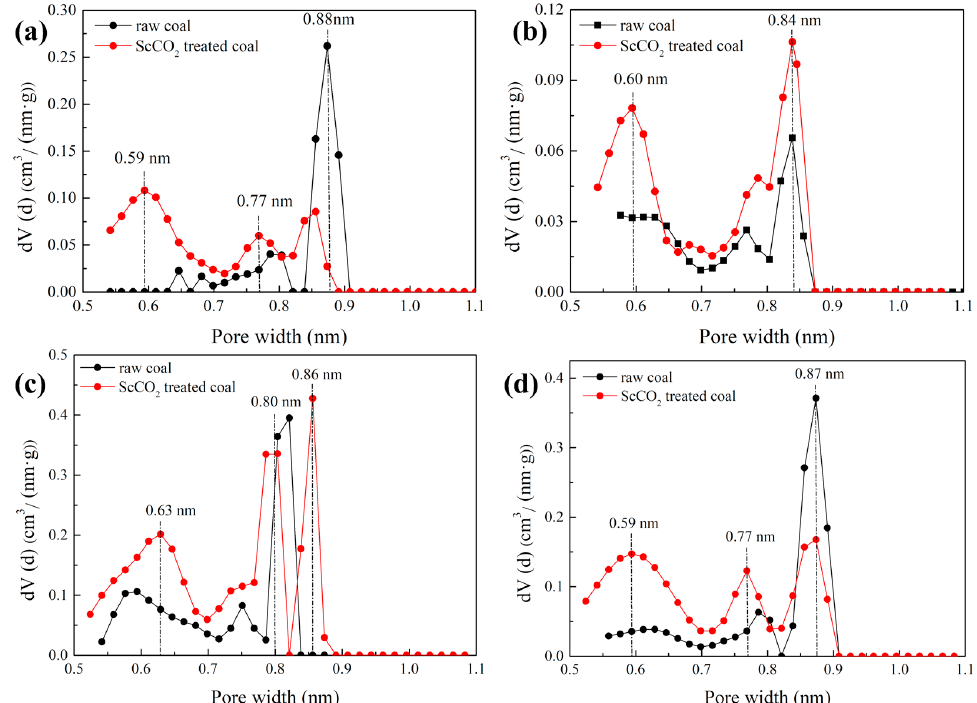
Figure 9. PSD for the raw and ScCO 2 -treated coal samples determined by CO 2 adsorption: ( a ) DL coal; ( b ) ZL coal; ( c ) GY coal; ( d ) DT coal.